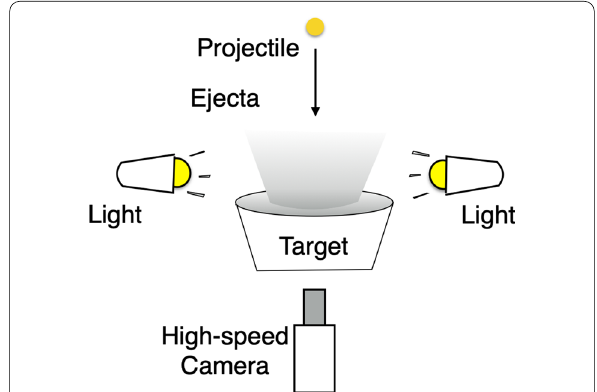
The target in the shot #540 consists of only 4 mm glass beads